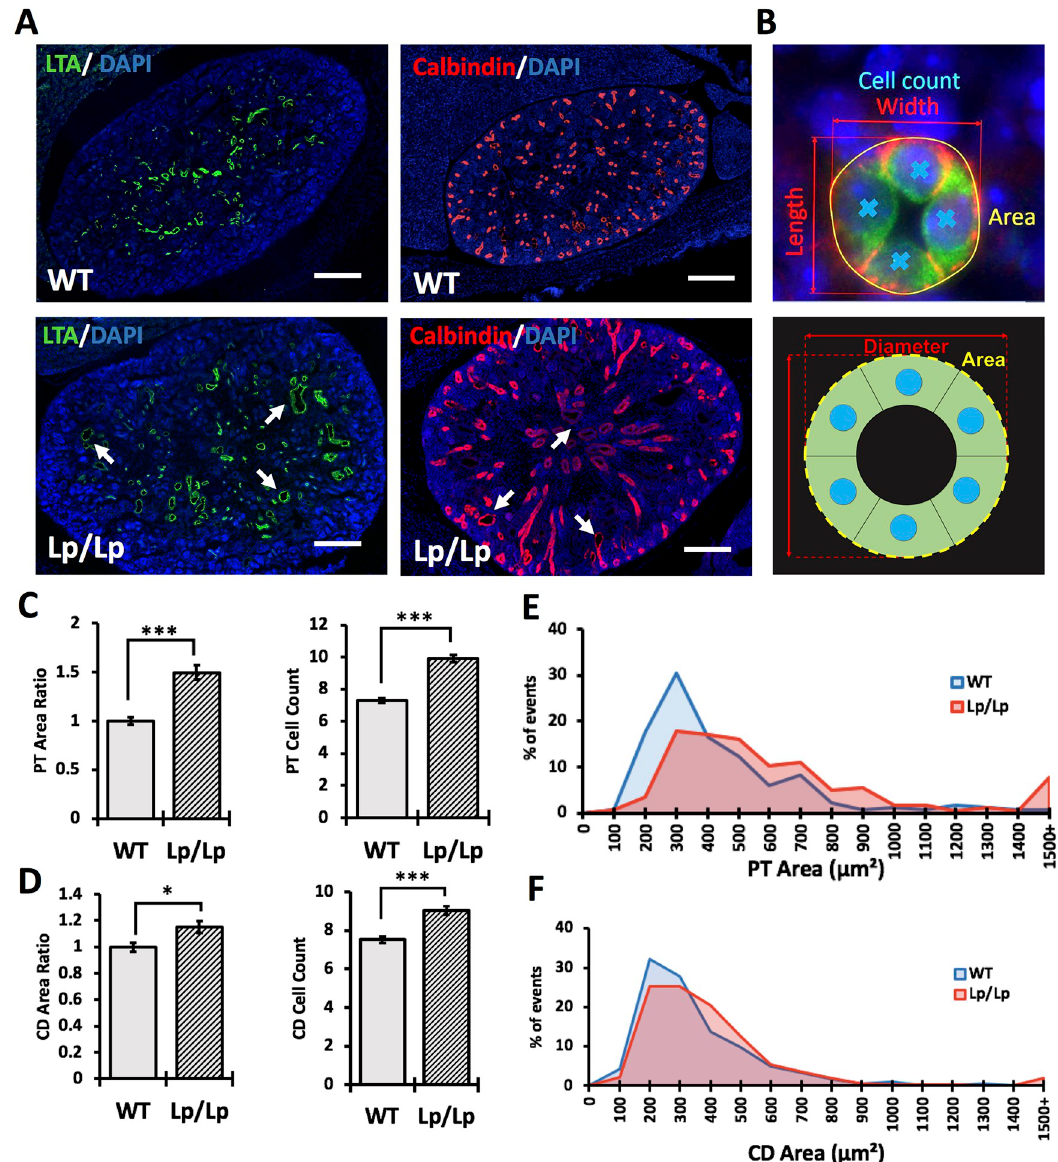
Fig 1. Kidney phenotype in Looptail embryos. (A) Immunofluorescence staining of E17.5 wildtype and Looptail kidney sections with LTA (marker for proximal tubules, green) and 4 0 ,6-diamidino-2-phenylindole (DAPI, marker for nuclei, blue), anti-Calbindin antibody (marker for collecting ducts, red) and DAPI. Scale bars, 100 μ m. (B) Immunostaining (upper image) and schematic representation (lower image) of measurements of area (yellow), diameter (red) and cell count (blue) in tubular cross-sections. (C) Measurements of proximal tubule (PT) area ratio and cell count: WT (n = 181), Lp/Lp (n = 280). The average area in wildtype tubules is considered “1” and the ratio of the mutant-to-control tubular area is calculated. (D) Measurements of collecting duct (CD) area ratio and cell count: WT (n = 183), Lp/Lp (n = 310). (E) Percentage of events within a given range of cross-sectional area in proximal tubules. (F) Percentage of events within a given range of cross-sectional area in collecting duct tubules. Mean ± standard error of mean is shown in all graphs; p < 0.05 ( � ), p < 0.001 ( �� ), p < 0.0001 ( ��� ). insertion of a LoxP site into Intron 3 results in an extra 50 bp (Fig 2A and 2B). By crossing the Vangl2 Fl/Fl mouse with the MORE-Cre mouse expressing Cre recombinase under control of the early embryonic Meox2 promoter [34], we generated a constitutive Vangl2 null “ Δ ” allele (600bp fragment lacking exon 4) vs a 1900bp fragment detectable in Vangl2 Fl/Fl animals (Fig